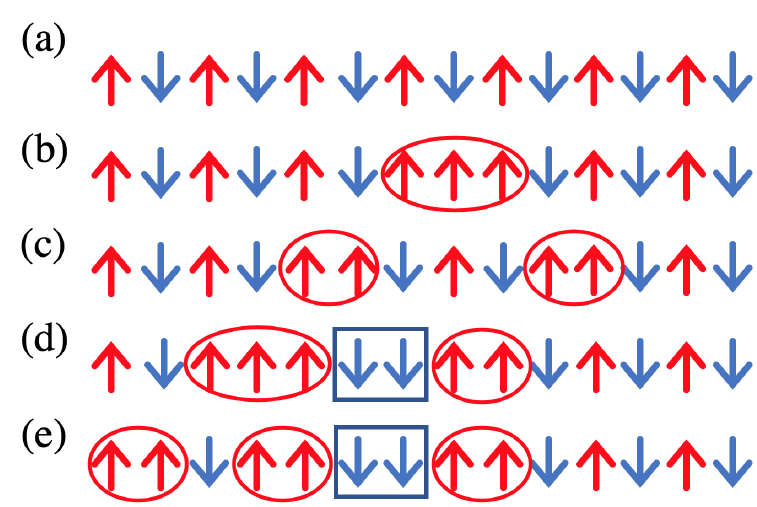
Figure 4: Possible configurations allowed in the variational Villain-like approach used in this work: a) Ising ground state; b) two confined spinons created after flipping one spin; c) two deconfined spinons; d) two confined spinons, one separate spinon and one anti-spinon; e) three spinons and one